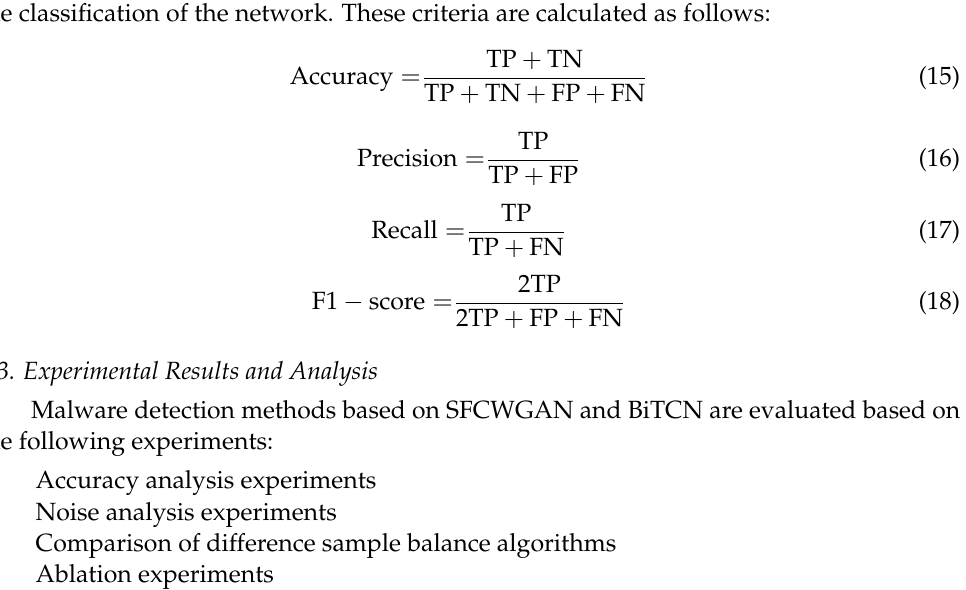
Figure 8. Ranking API in order of importance. Figure 7 shows that the most important Opcode feature is “MOV” and the least in- fluential is “LOOP”; similarly, Figure 8 shows that the most important API feature is “time” and “GetCommandLine” is the least influential. At the same time, different fea- tures have different importance, and the lower the importance of a feature, the less impact it has on the classification. In this way, invalid features can be filtered to retain the features with high importance and simplify the structure. XGBoost is used in combination with several optimization algorithms to analyze the importance of the features; strongly im- portant features are retained, and redundant features can be filtered out. In this paper, ref. [30], three optimization algorithms are used to compare. WOA- XGBoost was used to compare the gray wolf optimizer (GWO)-XGBoost, and Bayesian optimization (BO)-XGBoost was used to determine the importance ranking of features and to analyze the detection accuracy of these models. This is shown in Table 3. Table 3. Quantity Distribution of Sample DataCon Dataset.